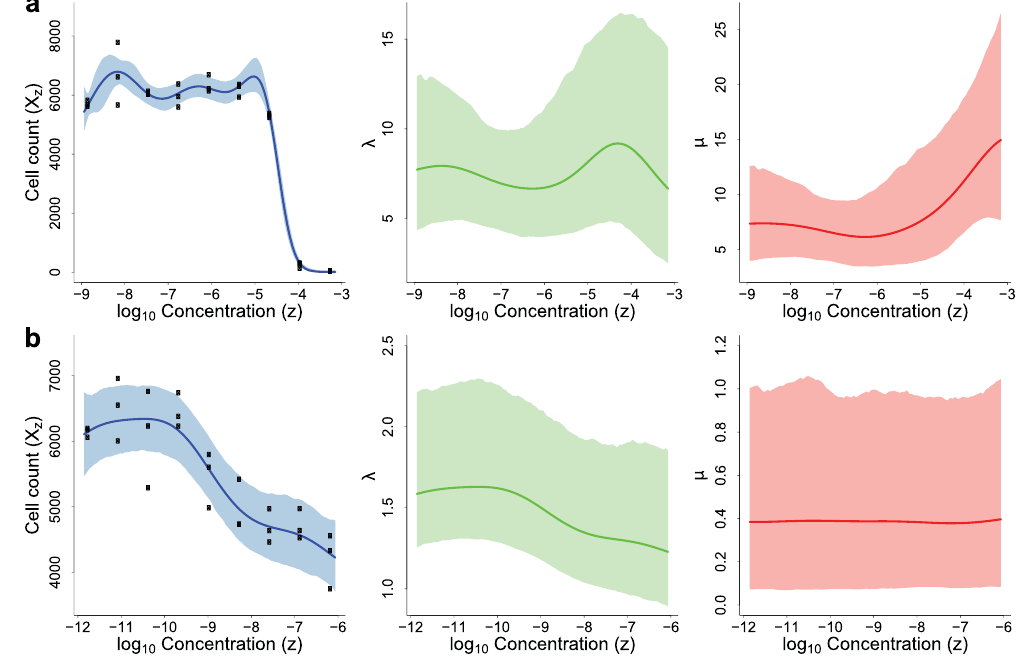
Figure 3. Posterior estimations of Kendall Process means (dose-response curves, left panel), birth rates (middle panel) and death rates (right panel) of cell line BT474 treated with compound Imatinib ( a ) and cell line HCC1806 treated with compound Cetuximab ( b ). Curves and shades represent the posterior mean and the 95% credible interval of the corresponding variables, respectively.